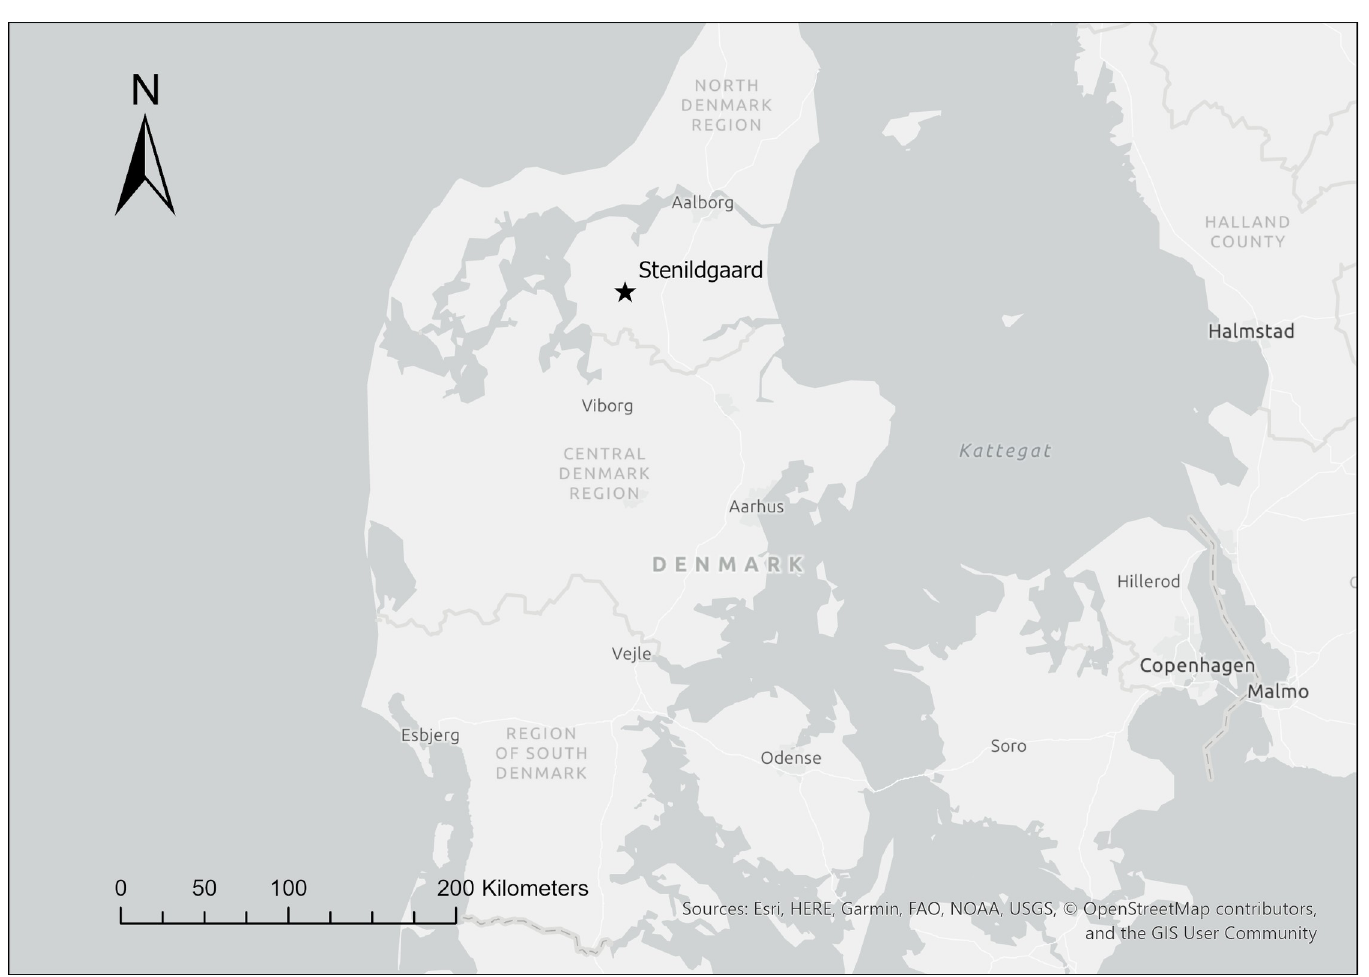
Fig 4. Map showing location of the Stenildg å rd area. The sites described below are all within < 2 km distance of each other. This map was generated using ESRI ArgGIS Pro software and basemaps, licensed to the National Museum of Denmark. The base map and data are from OpenStreetMap and OpenStreetMap